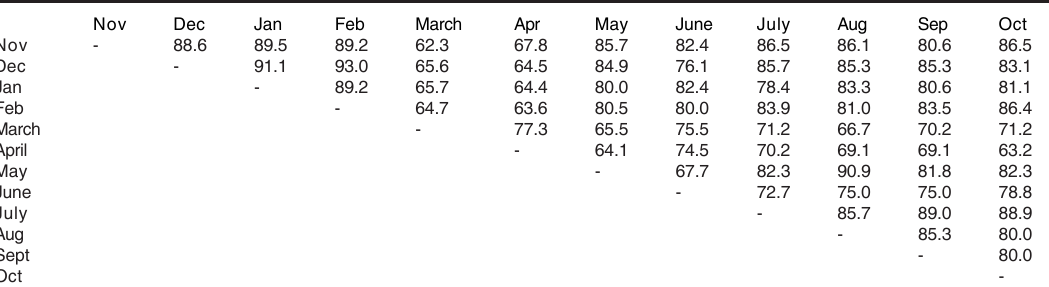
Table 3. Microcrustacea community similarities (Station I)